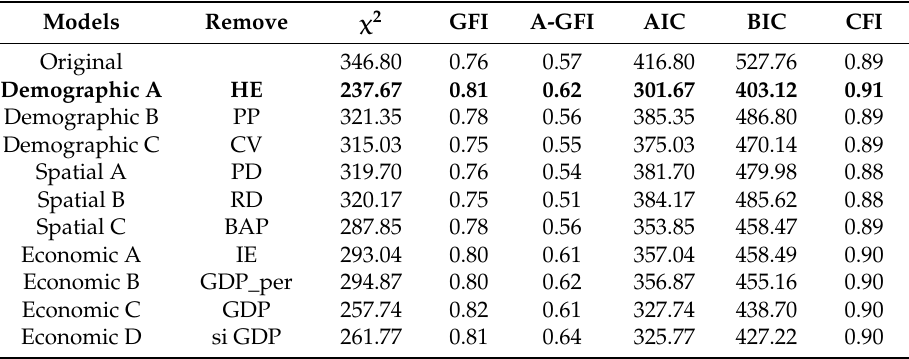
Table 2. Comparison of fitting results among models.